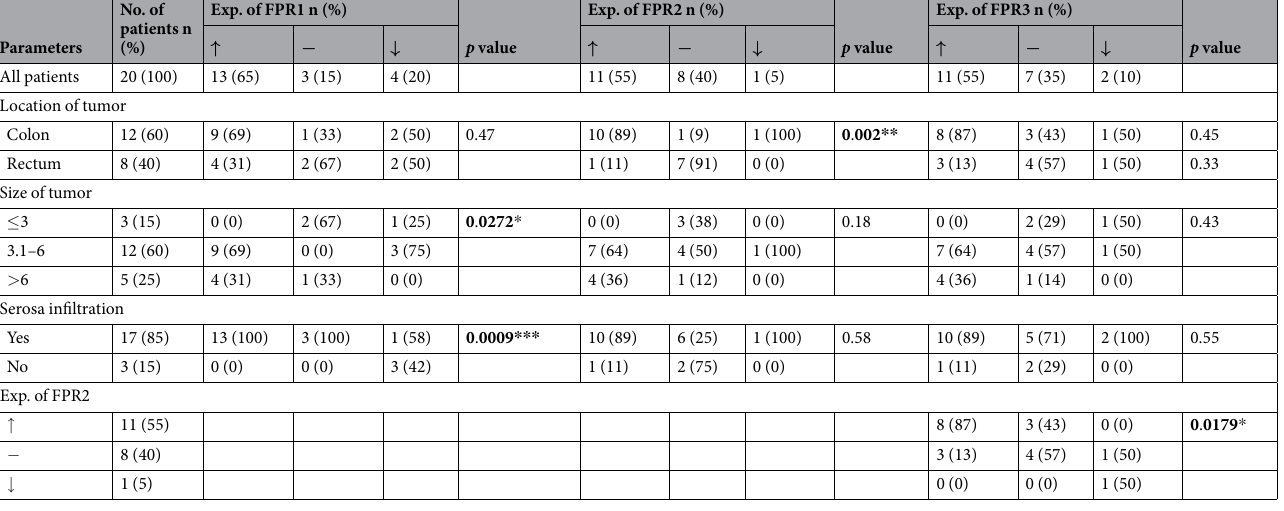
Table 1. FPRs and clinicopathological characteristics. Exp., Expression; * P < 0.05; ** P < 0.01; *** P <